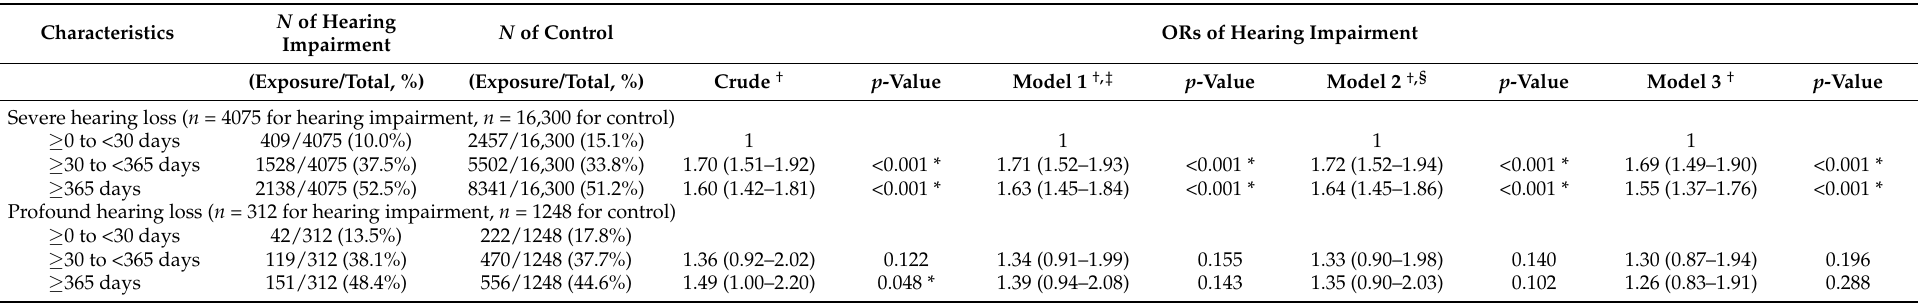
Table 3. Crude and adjusted odds ratios (95% confidence interval) of prescription dates of proton pump inhibitor for hearing impairment by severity of hearing impairment.